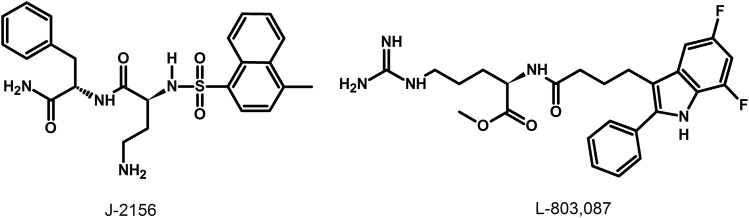
Structures of synthetic SST4 ligands. J-2156 and L-803,087, SST4 agonists.